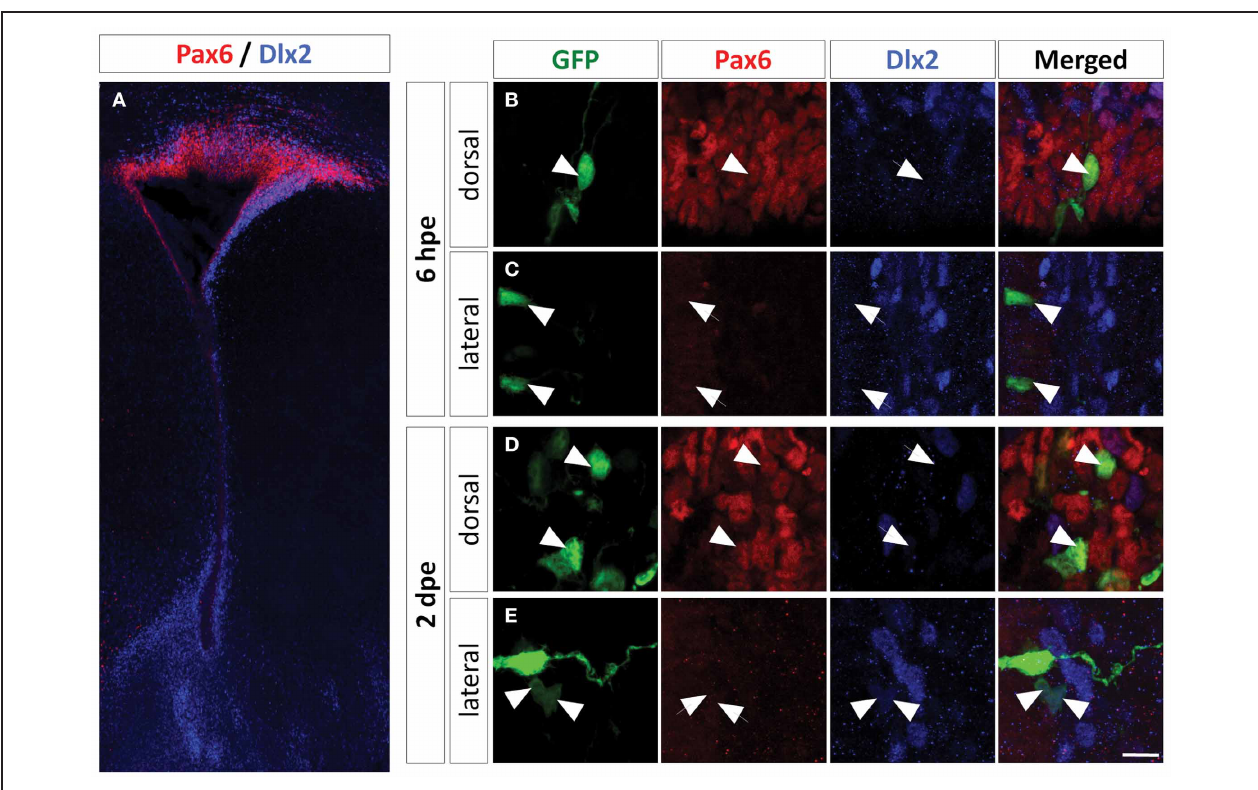
electroporation. Note that the dorsally electroporated cells expressed Pax6 but not Dlx2 (B,D) . As expected the laterally electroporated cells did not express Pax6 at any time. The lateral radial glial neural stem cells did not express Dlx2 at 6hpe (C) , while the transit-amplifying and neuroblast progeny did express Dlx2 at 2dpe (E) . Arrowheads: GFP + /marker + cells, arrows: GFP + /marker − cells. Scale bar: 10 μ